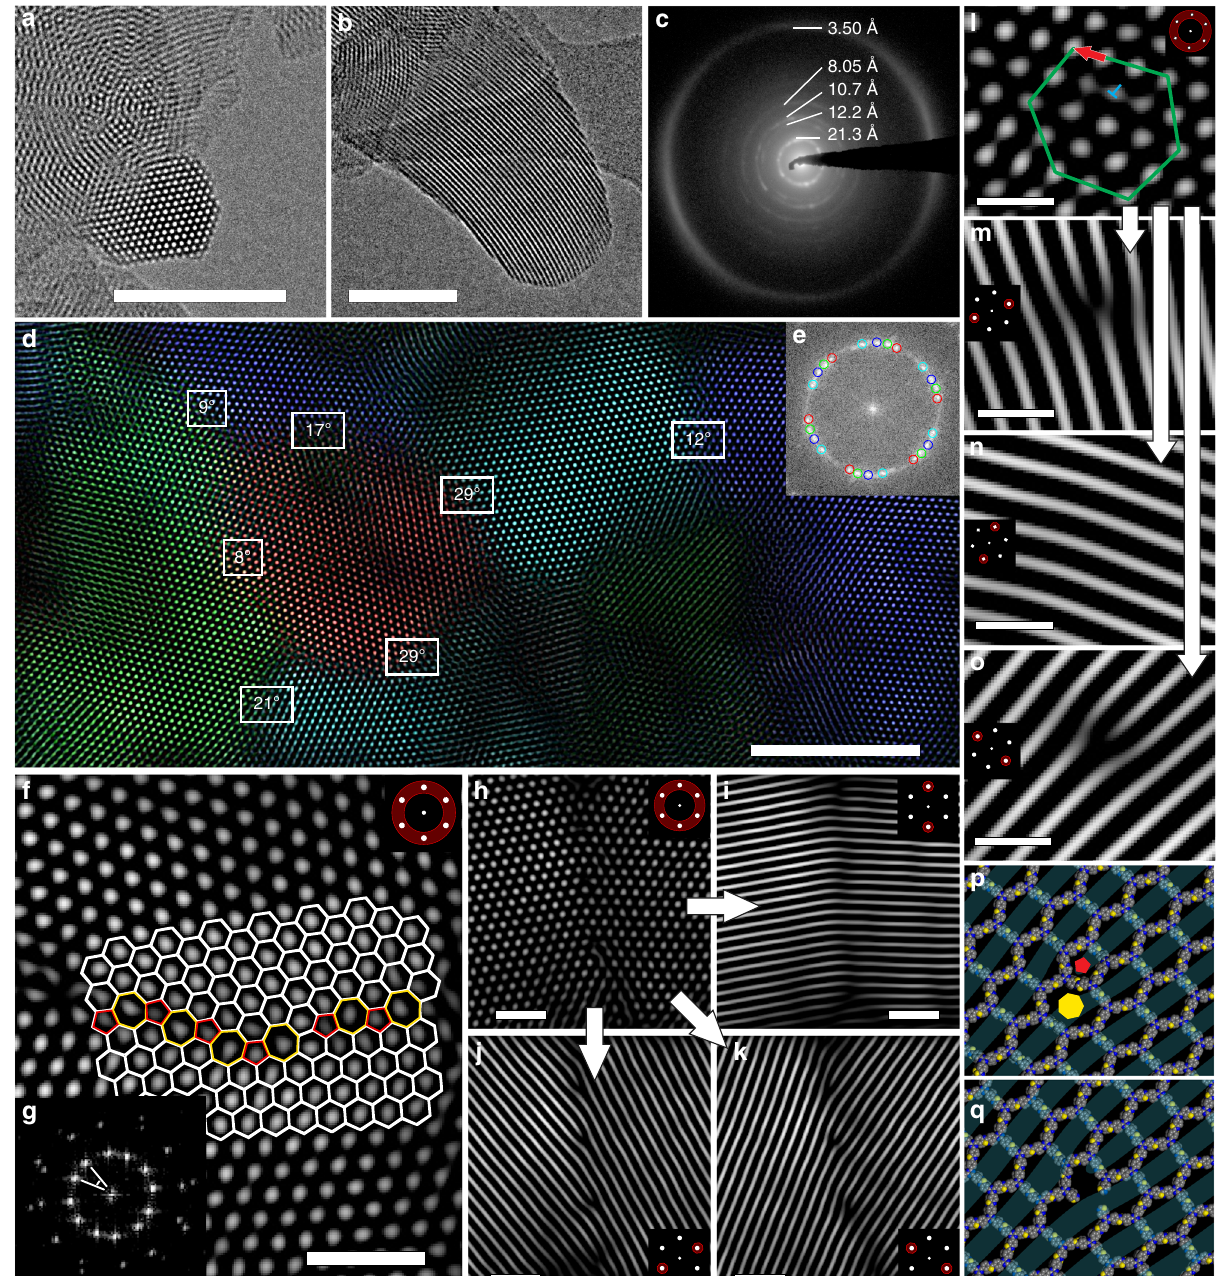
Fig. 6 TEM images and TEM analysis of TTT-COF. FFT fi lters applied to the image are indicated by a schematic inset. a , b Individual crystallites in different orientations. c SAED with logarithmic contrast showing diffraction rings, which are in agreement with the XRPD pattern. d Multiple inter-grown grains visible by TEM. Indicated angles show the relative orientation of neighboring crystallites. Color overlay indicating the individual grains generated by applying selective hexagonal Fourier fi ltration ( e ). f High angle grain boundary of crystallites with co-aligned c direction with an overlay indicating the interface consisting of fi ve, six and seven membered rings. g FFT of image f . h – k Low angle grain boundary with different Fourier fi lters applied, visualizing the starting points of edge dislocations. l Close-up of the start of an edge dislocation. The beginning of the edge dislocation is indicated by the blue T , the Burgers vector (red arrow) is determined from the green hexagon to be [100]. m – o Visualization of the edge dislocation position from image l with different Fourier fi lters. p , q Modeling of an edge dislocation in Materials Studio utilizing a screw dislocation along the pentagonal (red pentagon) and the heptagonal channel (yellow heptagon) ( p ) and the edge dislocation visualized as a channel linker vacancy ( q ). Scale bars: a , b , d : 50 nm; f , h – k : 10 nm; l – o : 5